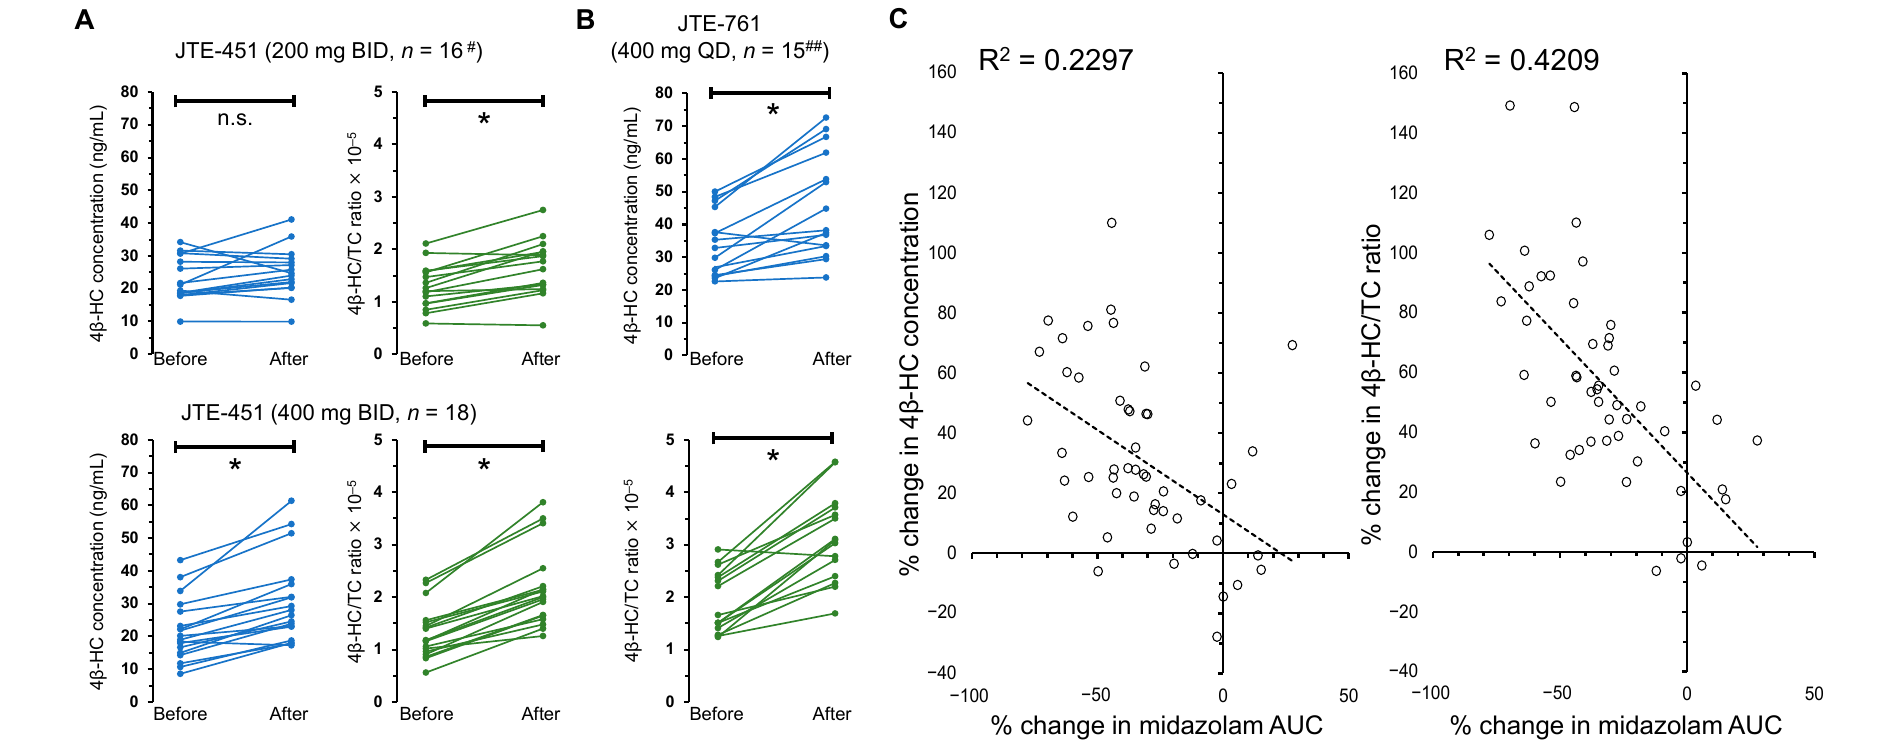
Figure 3. The 4 β -HC concentrations and 4 β -HC/TC ratios before and after the repeated administration of JTE-451 ( A ) and JTE-761 ( B ). The correlation chart between plasma 4 β -HC concentrations or 4 β -HC/TC ratios and the AUC of midazolam ( C ). Clinical DDI studies were conducted using weak inducers of CYP3A4 (JTE-451 and JTE-761), and blood collection and plasma sample storage were performed based on the results of 4 β -HC stability tests. Midazolam and 4 β -HC were measured using plasma, and the total cholesterol was measured using serum. The percentage (%) changes in 4 β -HC concentration, 4 β -HC/TC ratio, and midazolam AUC demonstrate their differences before and after the administration of NCEs. # Two subjects out of eighteen subjects opted out of the clinical study. ## One subject out of sixteen subjects opted out of the clinical study. * p < 0.01, n.s.: not significant.